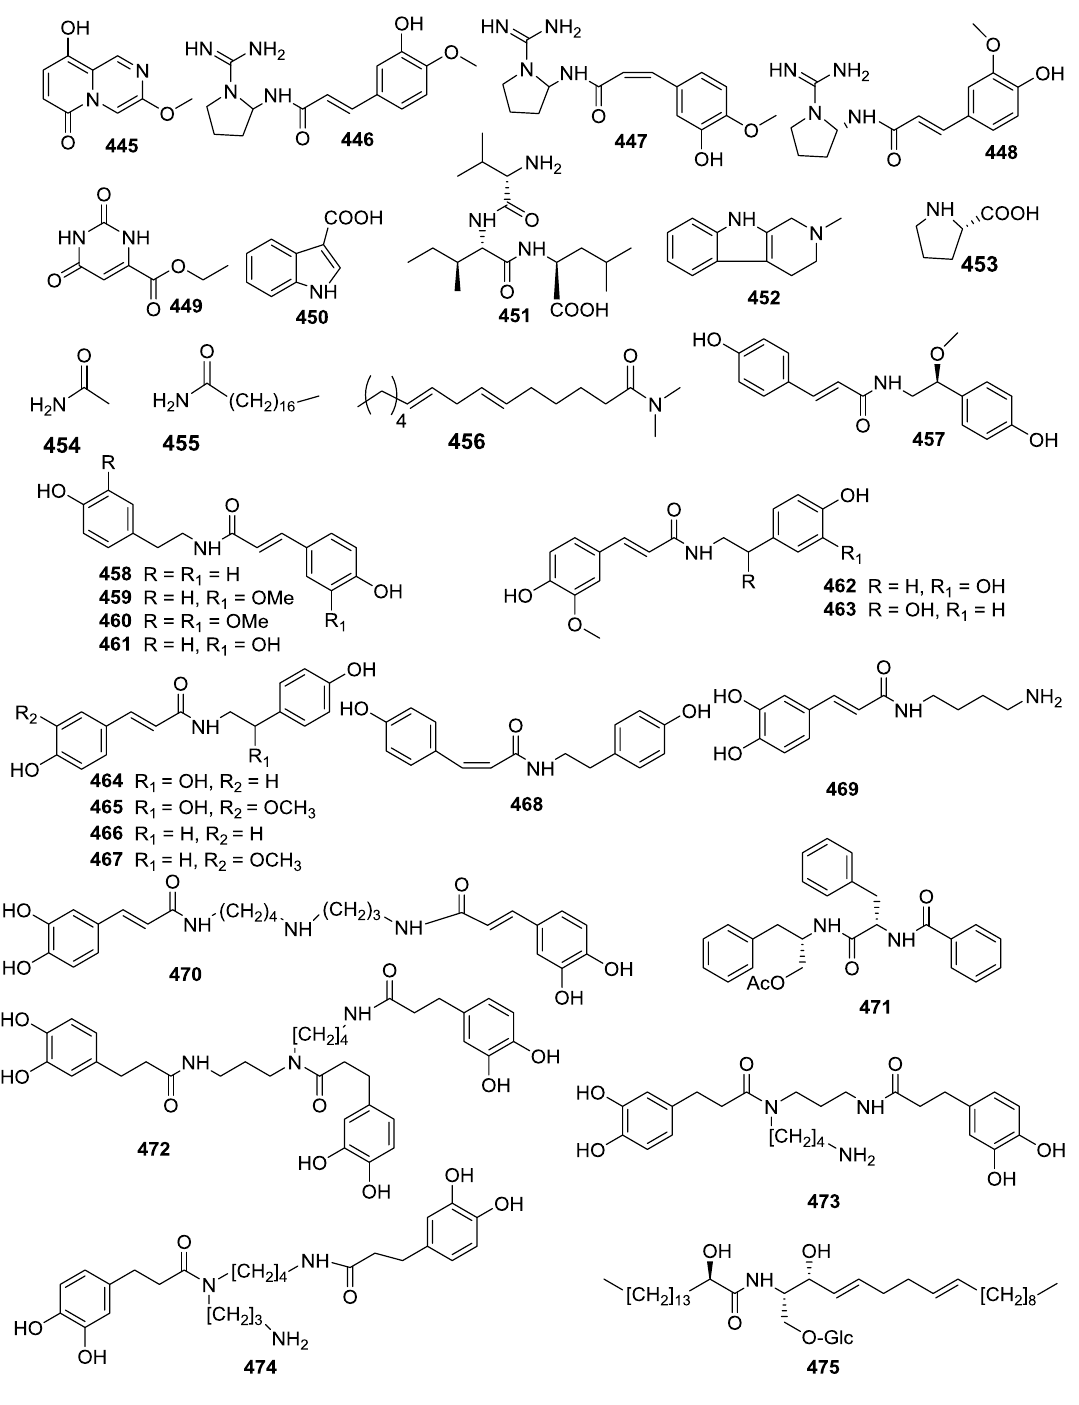
Fig. 10 Other alkaloids 445 – 475 from